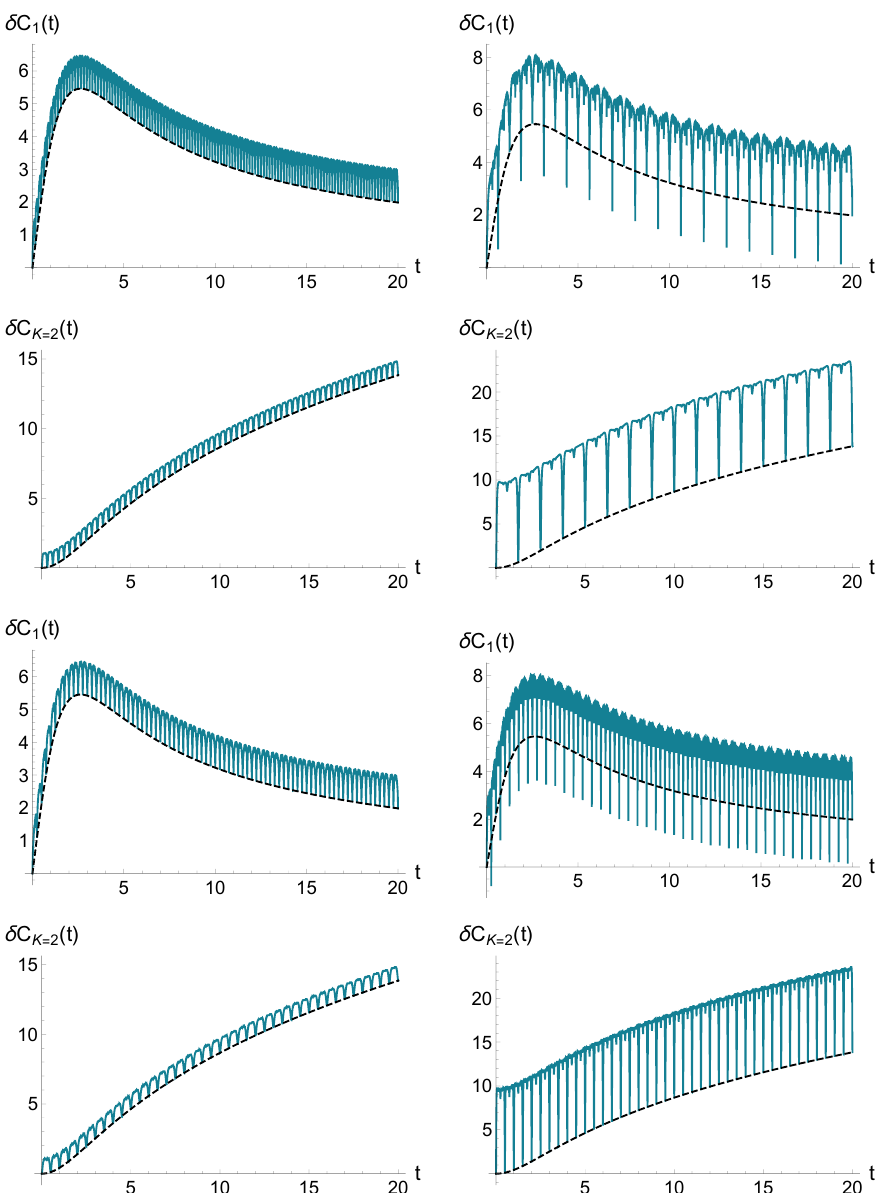
Figure 28 . Positive (left) and negative modes (right) contributions to the complexity variation δ C ( t ) for the Hamiltonian evolutions H + Ω J (first two rows) and H (last two rows). Both positive and negative modes sum include the zero mode contribution (in dashed black). The plots have been produced choosing L = 1 , N = 200 , µ = 1 , m = 10 − 6 , Ω = 0 . 6 , T = 10 as in the central panels of figure 23 and in figure